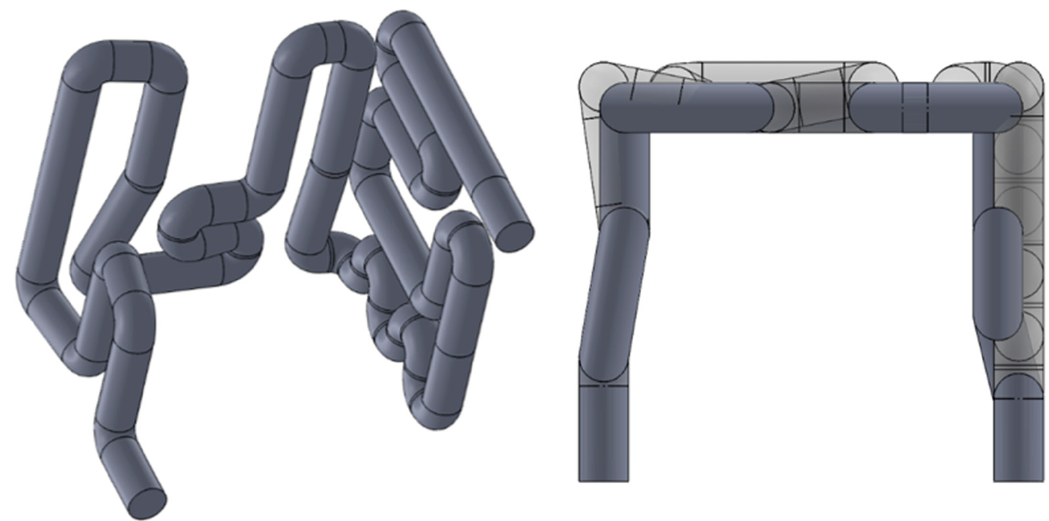
Figure 8. The design of the cooling circuit in the SLM-manufactured core module on the left and on the right a top view where it can be seen that this circuit (here transparent) reaches further towards the corners of the core module than the conventional one (here solid).